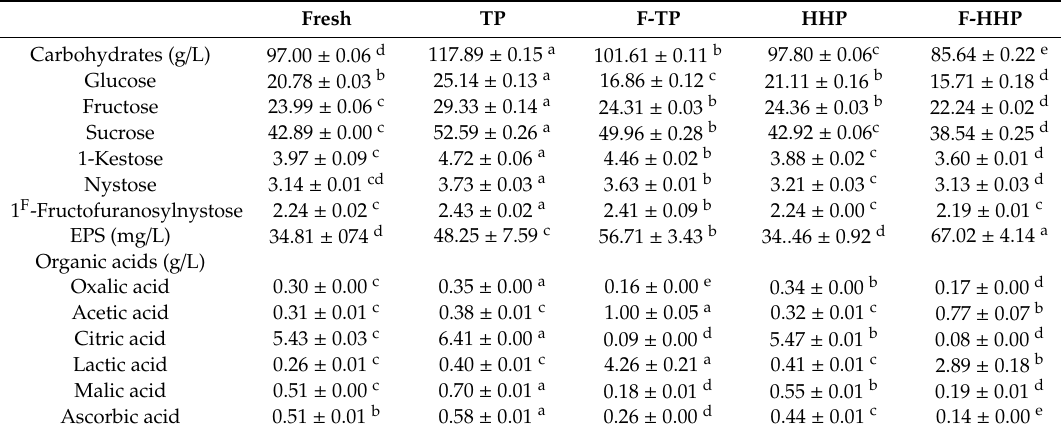
Table 1. Carbohydrate, exopolysaccharide (EPS), and organic acid content in di ff erent treated yacon-litchi-longan (YLL)